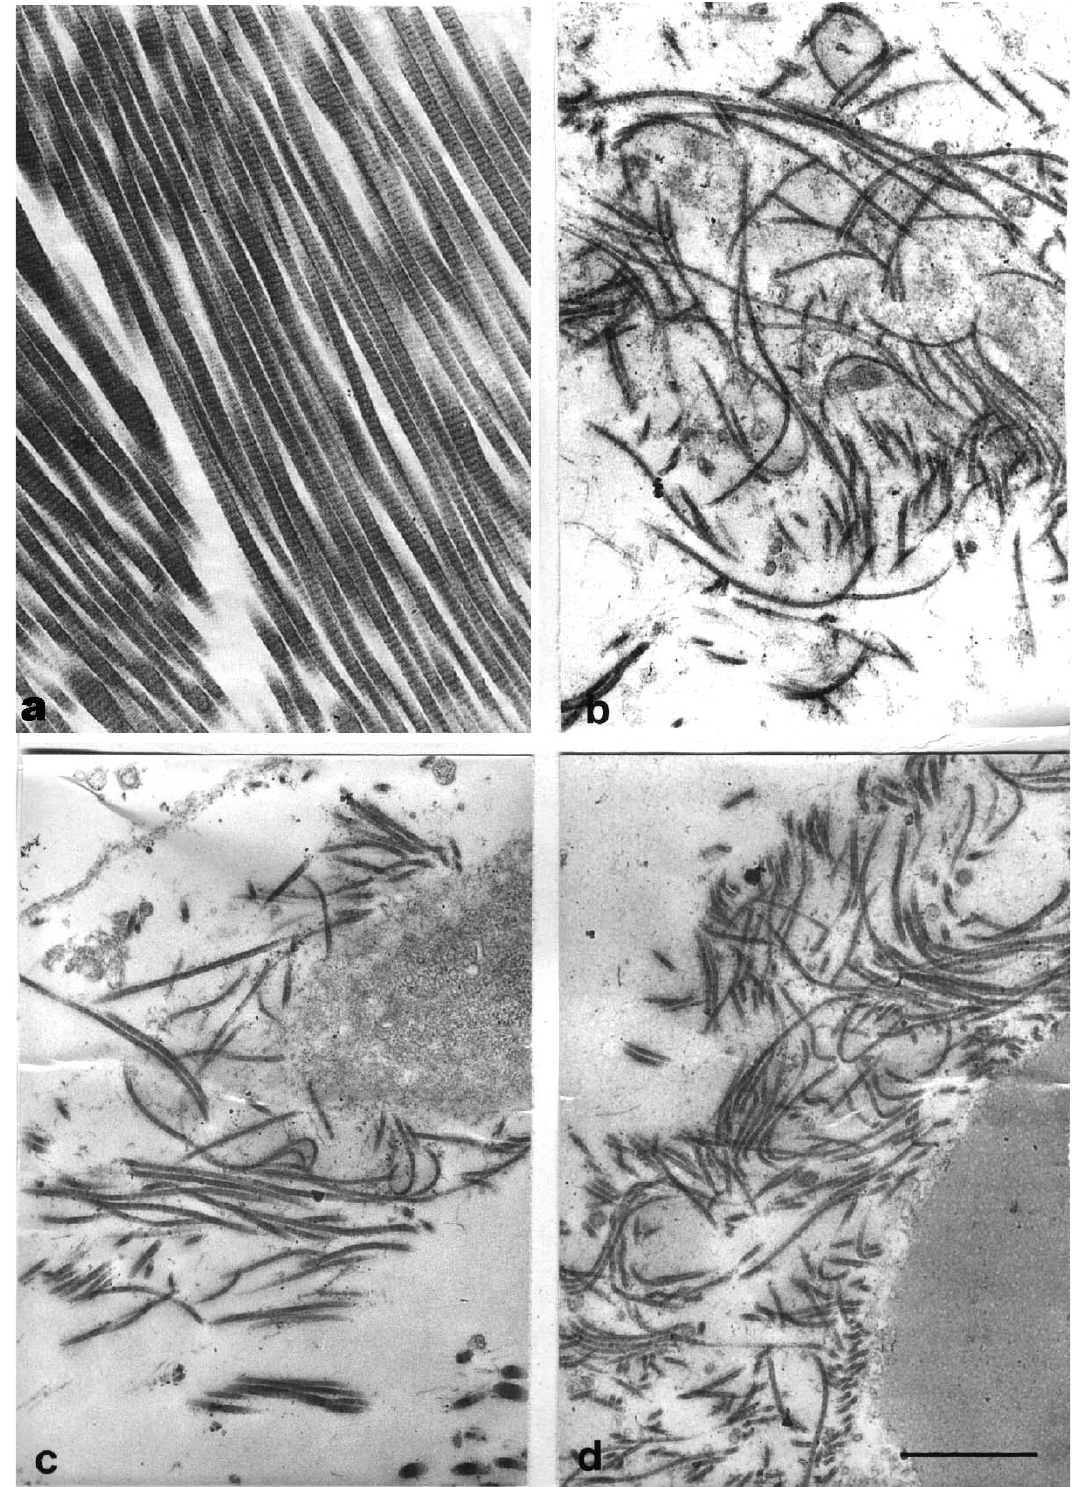
FIGURE 1. Electron micrographs of mouse skin collagen treated with 6 meq Li/kg for 30 consecutive days (b–d) demonstrating fibrils in disarray. In some regions, the characteristic parallel packing of fibrils is lost completely (b,d), whereas in others, it is preserved in a small part of the area (c). Animals were sacrificed (b) 1 day, (c) 2 months, and (d) 6 months after the last lithium injection. (a) Normal mouse skin fibrils. Bar = 1.0